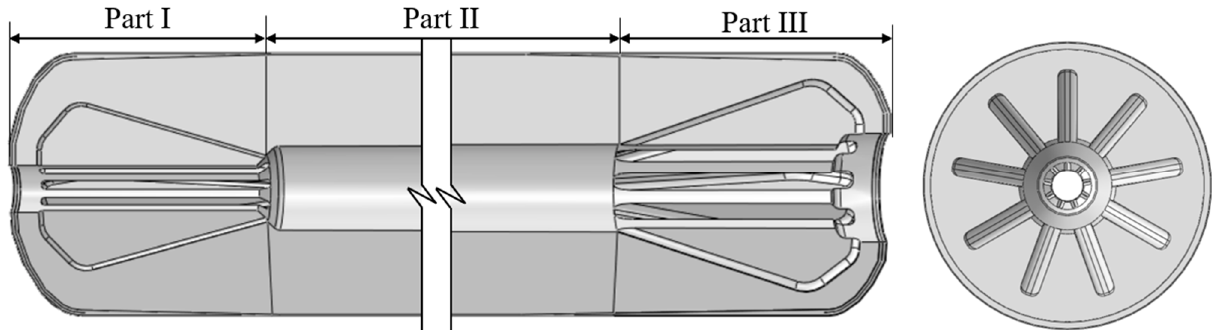
Figure 1. Geometric model of the SRM with finocyl grain.